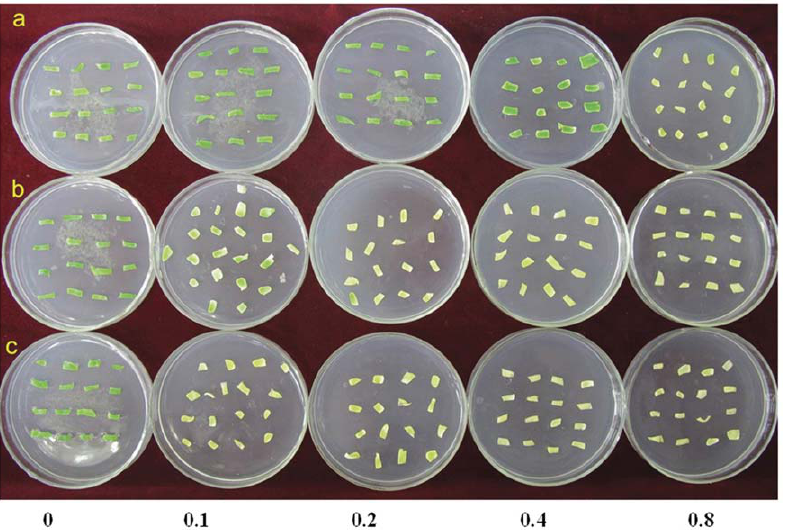
Figure 5. Herbicide resistance in leaf discs after 3 weeks in culture with glyphosate. Leaf discs from transgenic plants AroA R.aquatilis (a), AroA E.coli (b), and nontransformed control plants (c) were cultured on solid MS medium containing 0 to 0.8 mM glyphosate (columns 1–5 contained 0, 0.1, 0.2, 0.4, and 0.8 mM glyphosate, respectively).